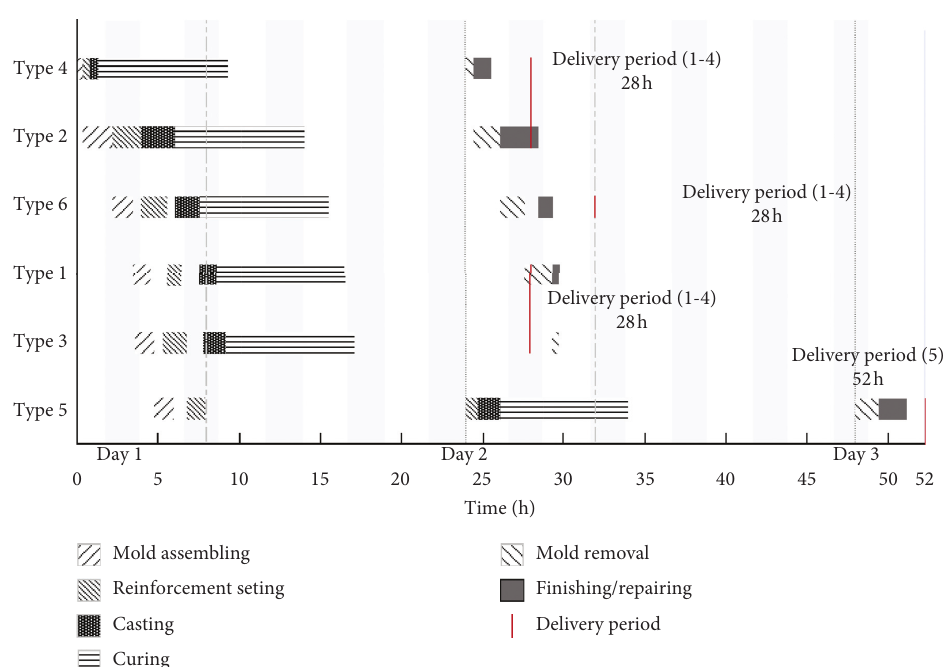
Figure 5: Gantt chart of completion time of each process based on the FSSM.